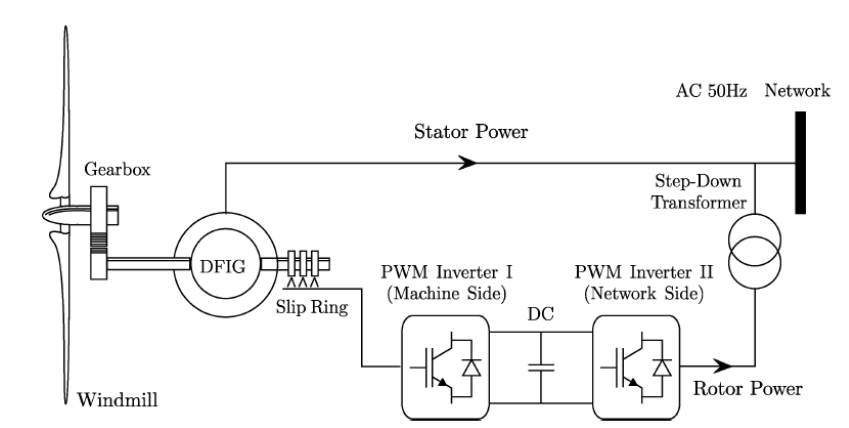
Figure 1. Scheme of a wind turbine system with a